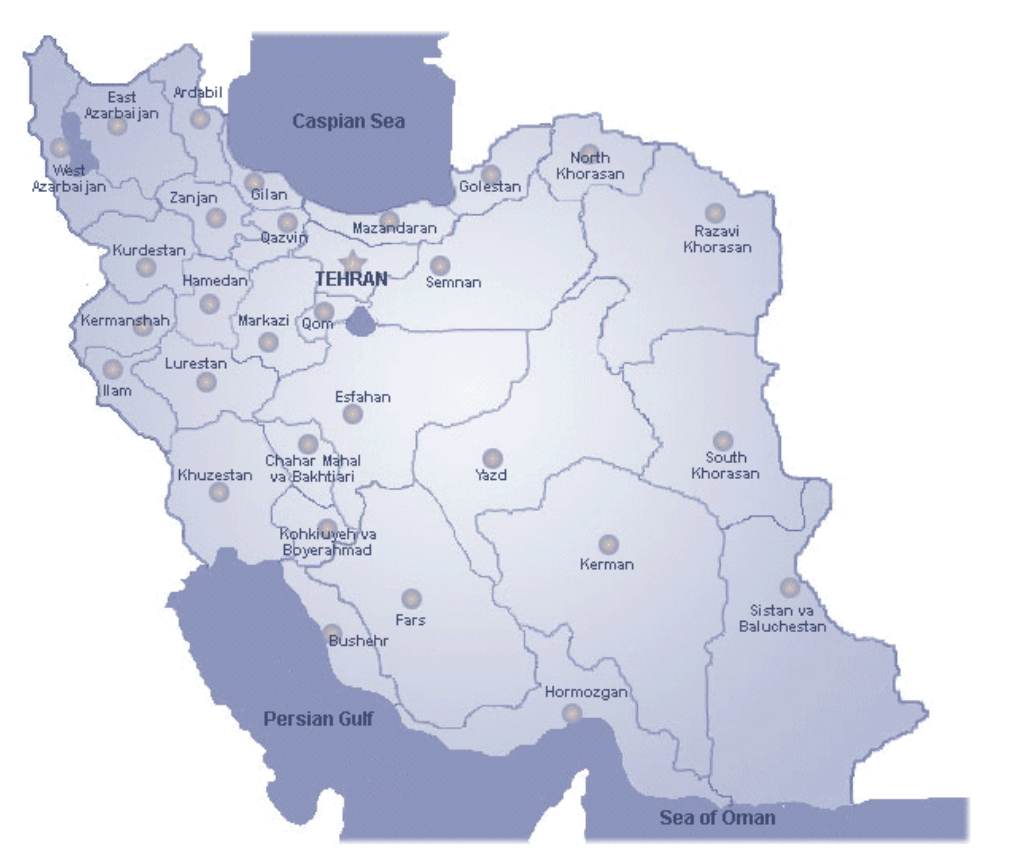
F IGURE 1. Map of Iran showing the politically divided provinces. T ABLE 1- Recorded distribution of the endemics within Iranian physiographic regions and